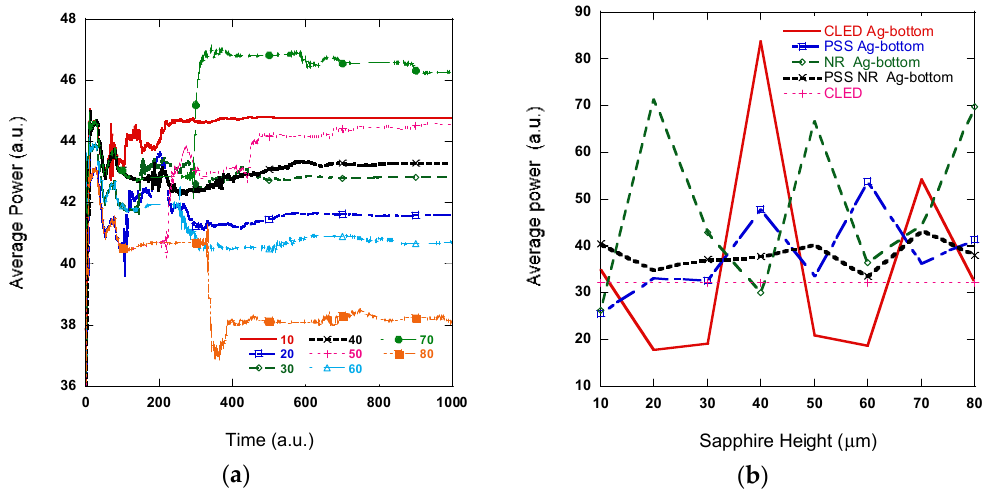
Figure 8. Average power vs. different sapphire substrate thicknesses with PSS NR and a bottom layer